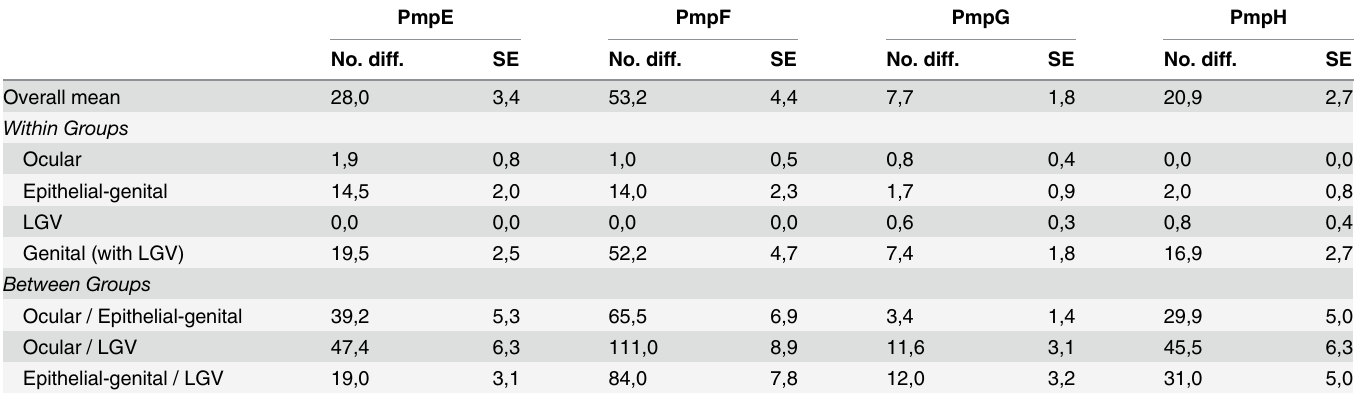
Table 1. Mean amino acid distances within the 1 st 600 amino acids of each